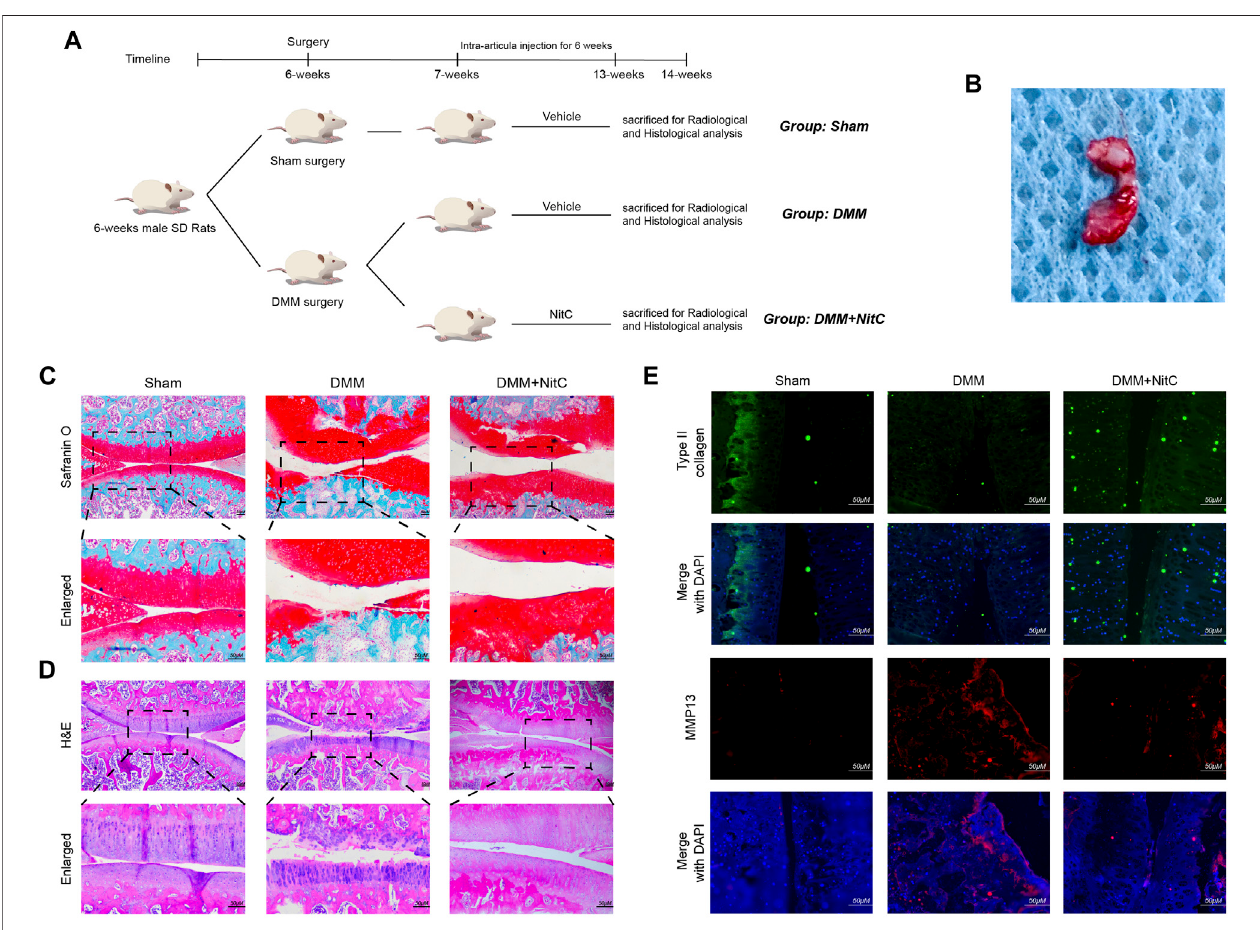
FIGURE 7 | Intra-articular injection of NitC ameliorated OA progression in rat OA model. (A) The fl owchart for animal procedures. (B) The resected medial meniscus. (C) Microscopic images of safranin O staining of rat knee joints. (D) Representative images of HE staining of rat knee joints. (E) Typical images of immuno fl uorescence analysis against type II collagen and MMP13. Scale bars = 200 μ M.